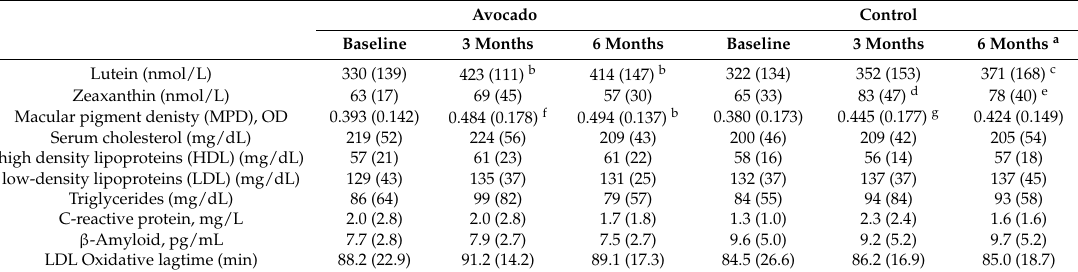
Table 3. Serum lutein, zeaxanthin, macular pigment density (MPD), blood lipids, markers of inflamation, and oxidative stress in healthy adults (>50 years) consuming one medium avocado a day (Avocado, n = 20) or one medium potato or one cup of chickpeas a day (Control, n = 20) for six months. Mean (SD). Avocado